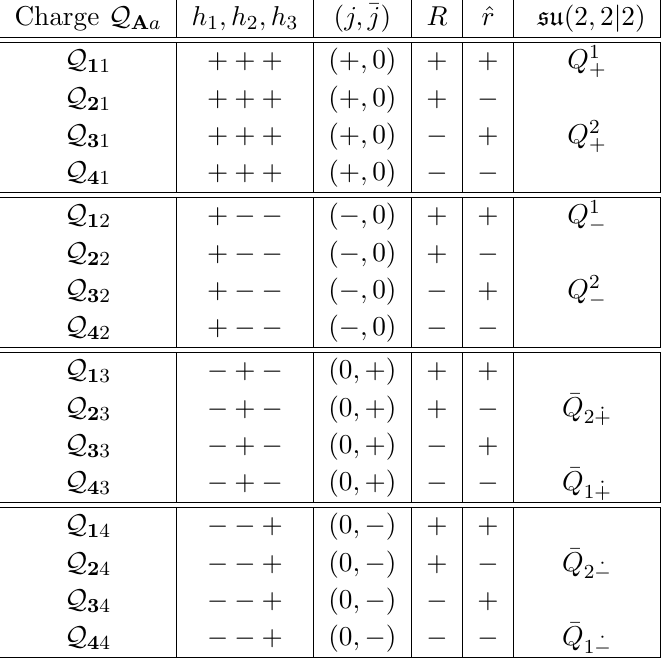
Table 3 . Supercharge summary for the 6D (2,0) SCA and its 4D N = 2 subalgebra. All orthogonal- basis quantum numbers have magnitude 1 h 3